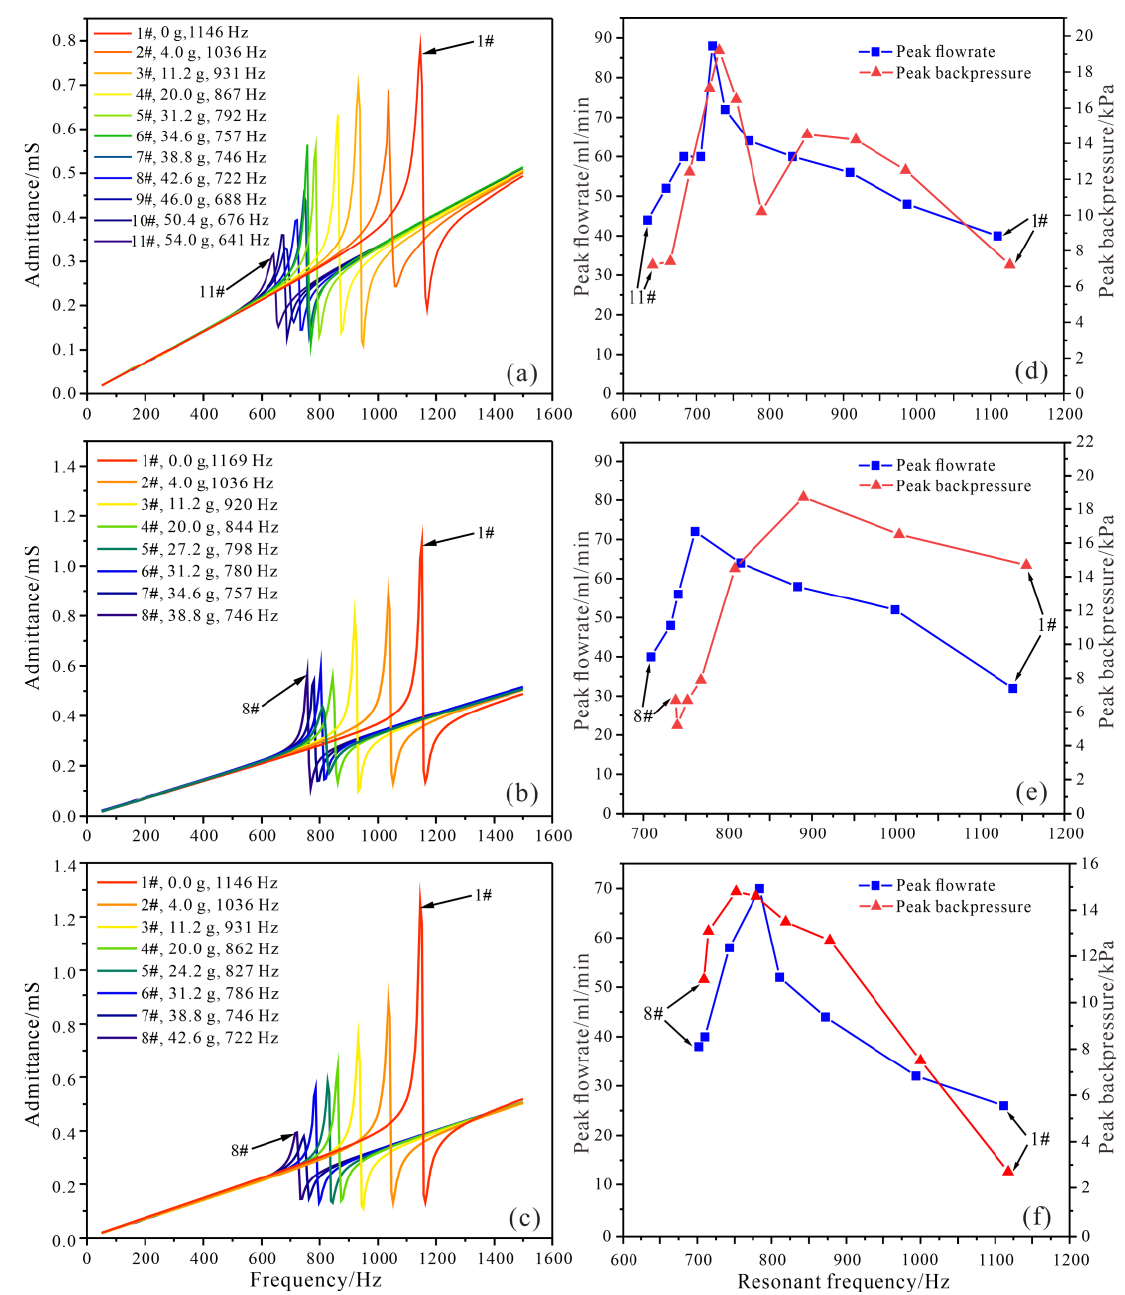
Figure 12. Frequency responses of admittances under different mass blocks of the piezoelectric pump using check valves with ( a ) 5 inlet holes, ( b ) 4 inlet holes, and ( c ) 3 inlet holes; relationships between the peak flowrate and backpressure with resonant frequency of the piezoelectric pump using check valves with ( d ) 5 inlet holes, ( e ) 4 inlet holes, and ( f ) 3 inlet